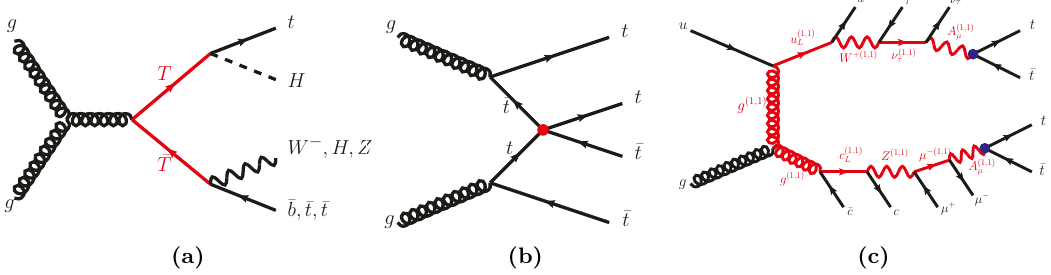
Figure 1. Representative leading-order Feynman diagrams for the signals probed by this search: (a) T (cid:22) T production, and (b) four-top-quark production via an e(cid:11)ective four-top-quark interaction in an e(cid:11)ective (cid:12)eld theory model, and (c) four-top-quark production via cascade decays from Kaluza- Klein excitations in a universal extra dimensions model with two extra dimensions compacti(cid:12)ed using the geometry of the real projective